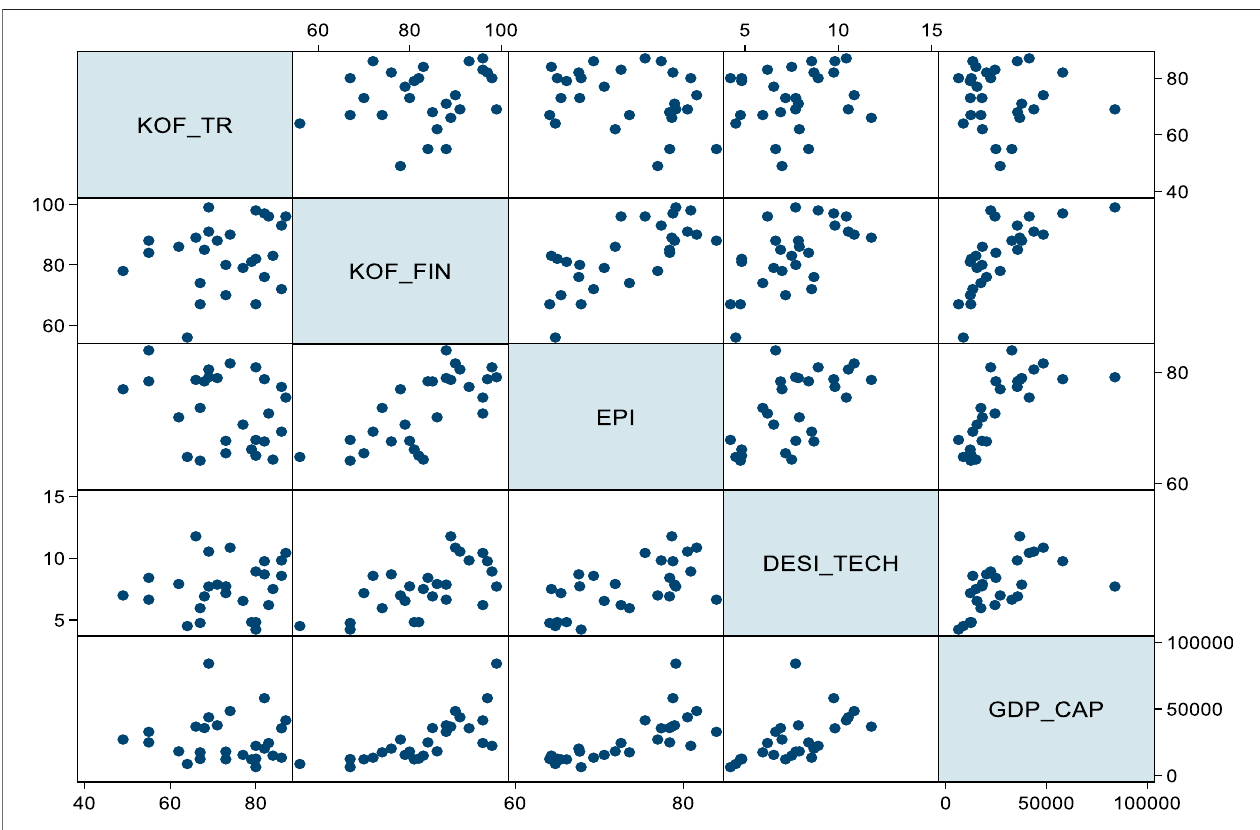
FIGURE 4 | | Correlation matrix for the main indicators used in clustering, EU-27, 2018. Source: Authors ’ contribution.